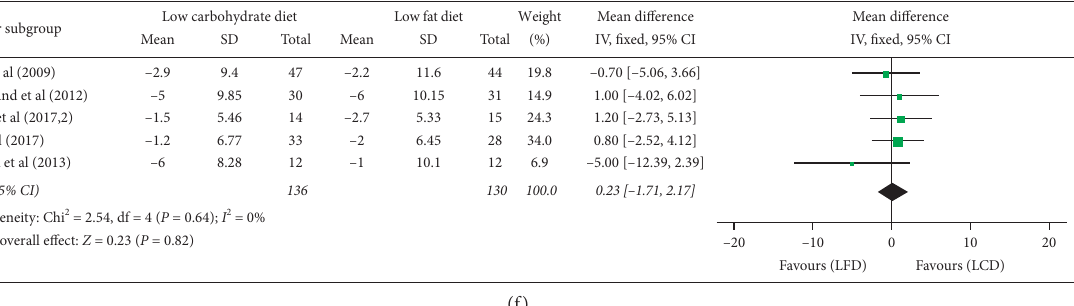
Figure 5: Forest plot for the effect of restriction diets on TC (a), TG (b), LDL-C (c), HDL-C (d), SBP (e), and DBP (f). TC: total cholesterol; HDL-C: high-density lipoprotein cholesterol; LDL-C: low-density lipoprotein cholesterol; TG: triglycerides; LCD: low-carbohydrate diet; LFD: low-fat diet; CI: confidence interval; SD: standard deviation.